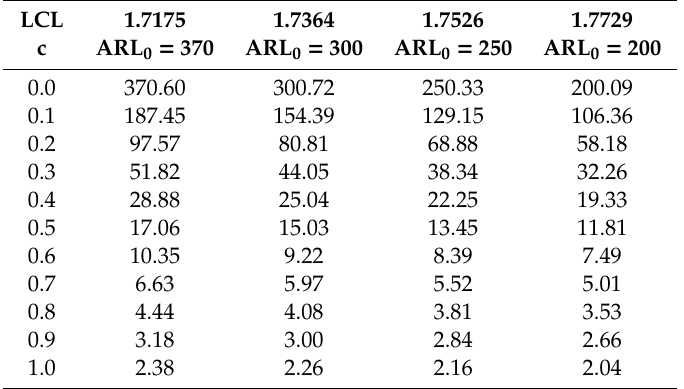
Table 2. The ARLs for the proposed chart when n = 50, WD (2.8,3.5), USL = 6.3488, and LSL = 0.5280.